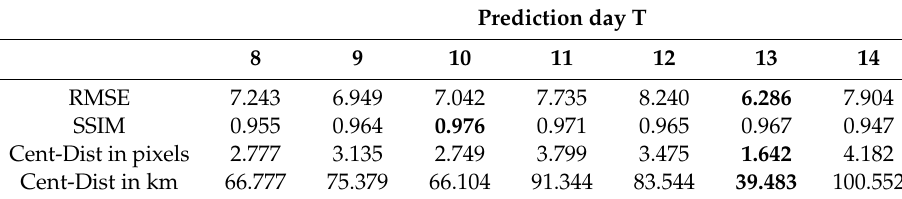
Table 13. Daily comparison of RMSE, SSIM, and centroid distance of case 4.